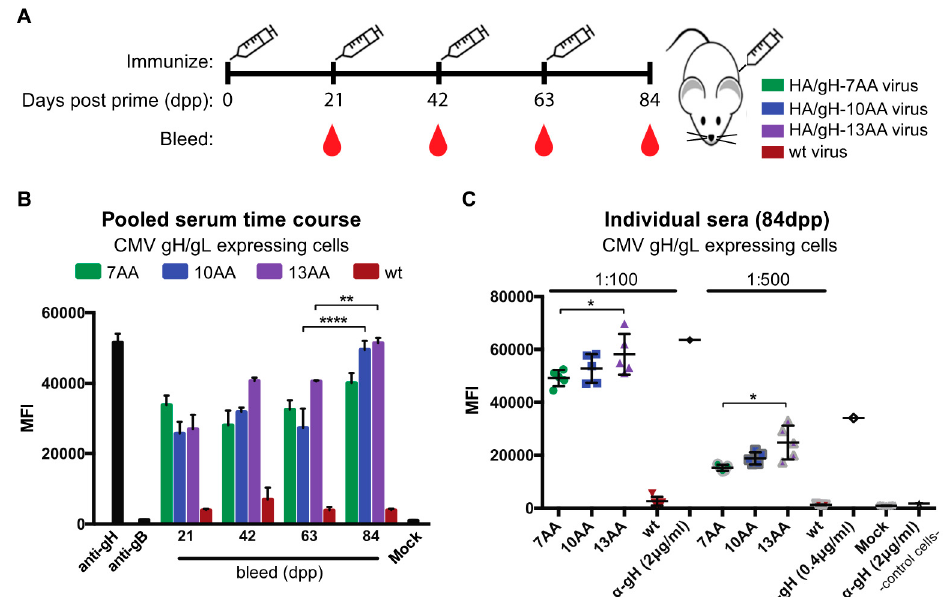
Figure 4. Chimeric influenza/CMV viruses generate a humoral response against CMV gH. ( A ) The immunization (syringe) and blood collection strategy for groups of five mice immunized with either chimera HA/gH viruses HA/gH-7AA (7AA), HA/gH-10AA (10AA), and HA/gH-13AA (13AA) or the wild type IAV virus (wt) lacking CMV components is depicted. Blood collection occurred prior to immunization. ( B ) Pooled sera from each immunization group was analyzed for specificity to cells expressing the CMV gH/gL dimer by measuring immunoglobulin binding followed by anti-mouse Ig-conjugated to Alexa647 ( α mouse-Ig Alexa647 ) with flow cytometry. Controls included anti-gH (10C10) and anti-gB (2F4) (2 and 0.4 µg/mL) mAbs as well as cells probed with only α mouse-Ig Alexa647 (Mock). ( C ) Serum from individual mice at 84 days post prime (dpp) was subjected to flow cytometry analysis of CMV gH/gL-expressing cells. Anti-CMV gH mAb were utilized as a positive and negative control, respectively. Mock represents cells probed with α mouse-Ig Alexa647 only and control cells refer to non-gH/gL expressing cells. The mean fluorescence intensity (MFI) was determined using FlowJo Software and the data points were from technical replicates with s.d. depicted. * p < 0.05, ** p < 0.01, **** p < 0.0001 (ANOVA).